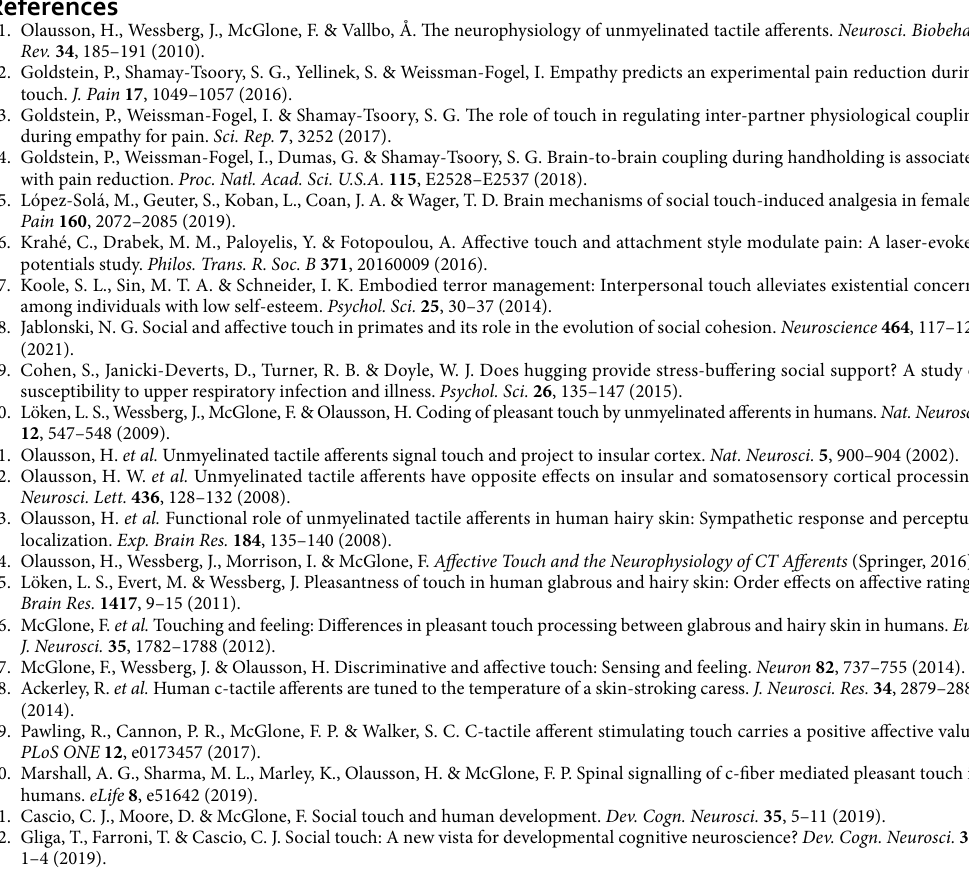
Table S8. All dependent variables were tested for normality of distribution using Kolmogorov–Smirnov or Sha- piro–Wilk analysis. ANOVA and Bonferroni post hoc analyses were conducted using the three factors of con- dition (C1, C2, and C3), time, and robot (NWR and WR); p < 0.05 was considered significant. All data were analyzed using IBM SPSS statistical software version 28 (IBM, Armonk, NY,